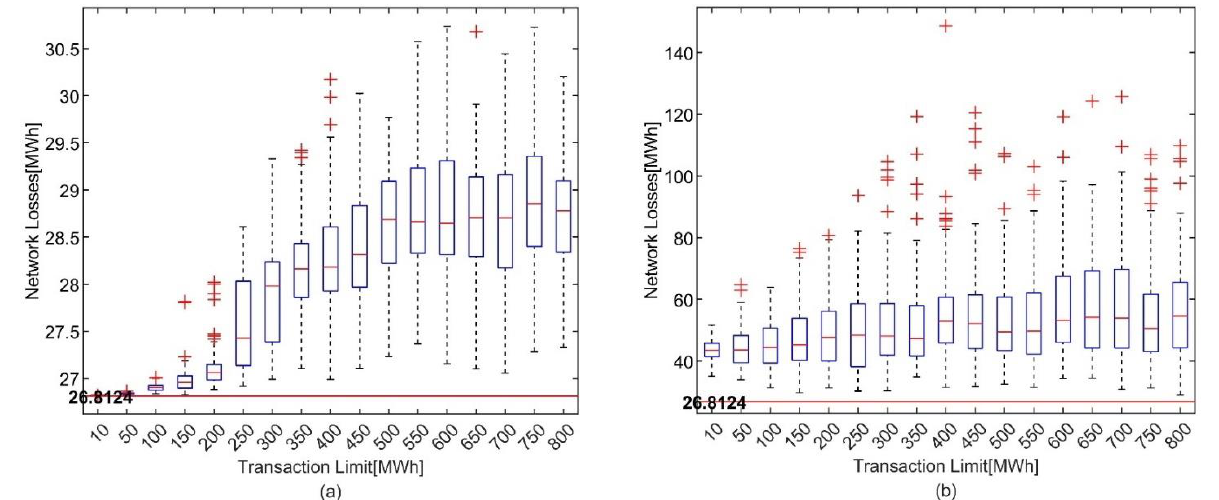
Figure 5. Distribution of network losses in the IEEE 39 bus system: ( a ) the guided case; ( b ) the random case.